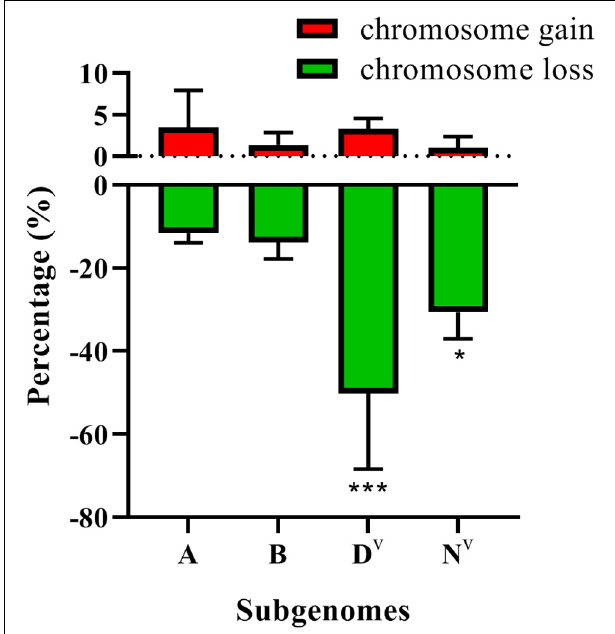
FIGURE 8 | The frequencies of subgenome loss and gain. P -values labeled with asterisks denote significant differences at * P < 0.05 and *** P <